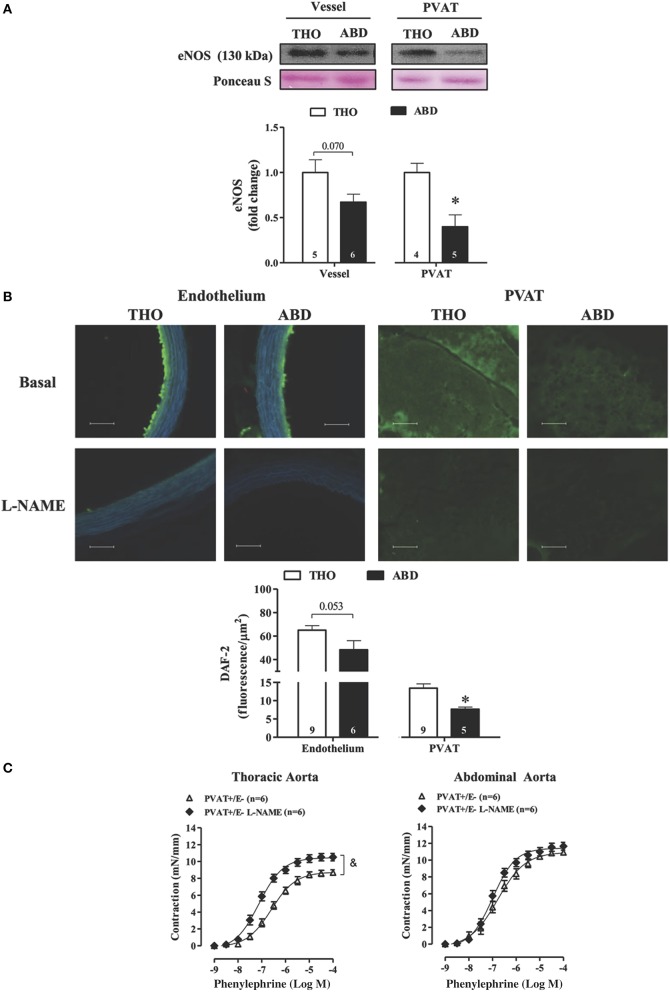
Reduced eNOS expression and NO availability in abdominal vs. thoracic perivascular adipose tissue (PVAT). (A) eNOS protein expression in vessel walls and PVAT from thoracic (THO) and abdominal (ABD) aorta. Representative blots and Ponceau S staining were demonstrated at the upper panels of the figure and densitometric analysis is expressed as a fold change of THO expression at the bottom panel. (B) Top panels-Representative fluorographs of 4,5-diaminofluorescein diacetate (DAF-2) signal obtained in transverse sections of vessel walls and PVAT from THO and ABD aortic tissues in the absence (upper panel) and presence (lower panel) of L-NAME. Scale bar = 100 μm (20X objective). Bottom panel-Quantified NO availability, measured as DAF-2 fluorescence intensity in the endothelial layer and PVAT of THO and ABD aorta. (C) Concentration-response curves to phenylephrine in rat thoracic (left panel) and abdominal (right panel) aorta without (−) endothelium (E) and with (+) PVAT in the absence or presence of L-NAME. Data are expressed as the means ± SEM; the number of animals is indicated in the bars or in parenthesis. Student's t-test, P < 0.05: *ABD vs. THO PVAT; Two-way ANOVA, P < 0.05: & PVAT+E− vs. PVAT+E− L-NAME.